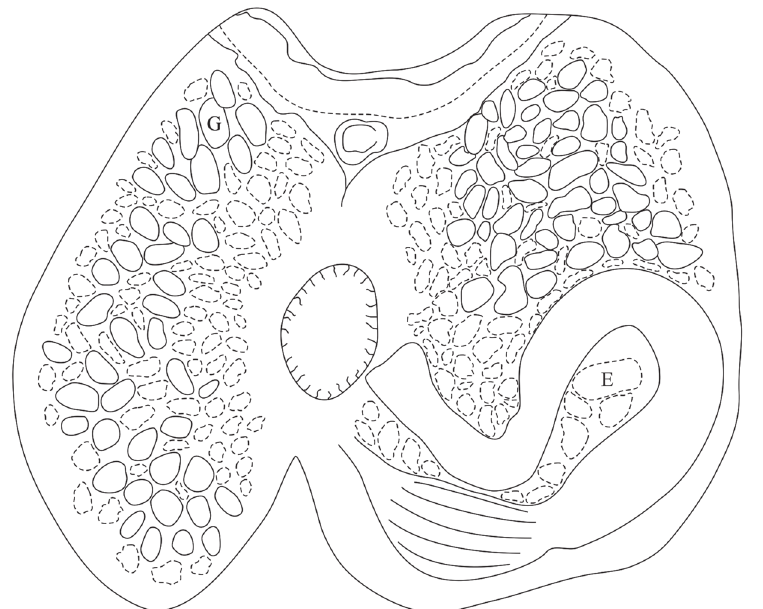
Figure 6. Polycarpa tumida , dissected individual without pharynx. (G) Gonad, (E) endocarp. Scale bar: 0.5